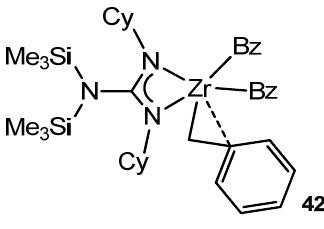
Figure 25. Zirconium complex with a η 2 -type bond interaction of a benzyl ligand.